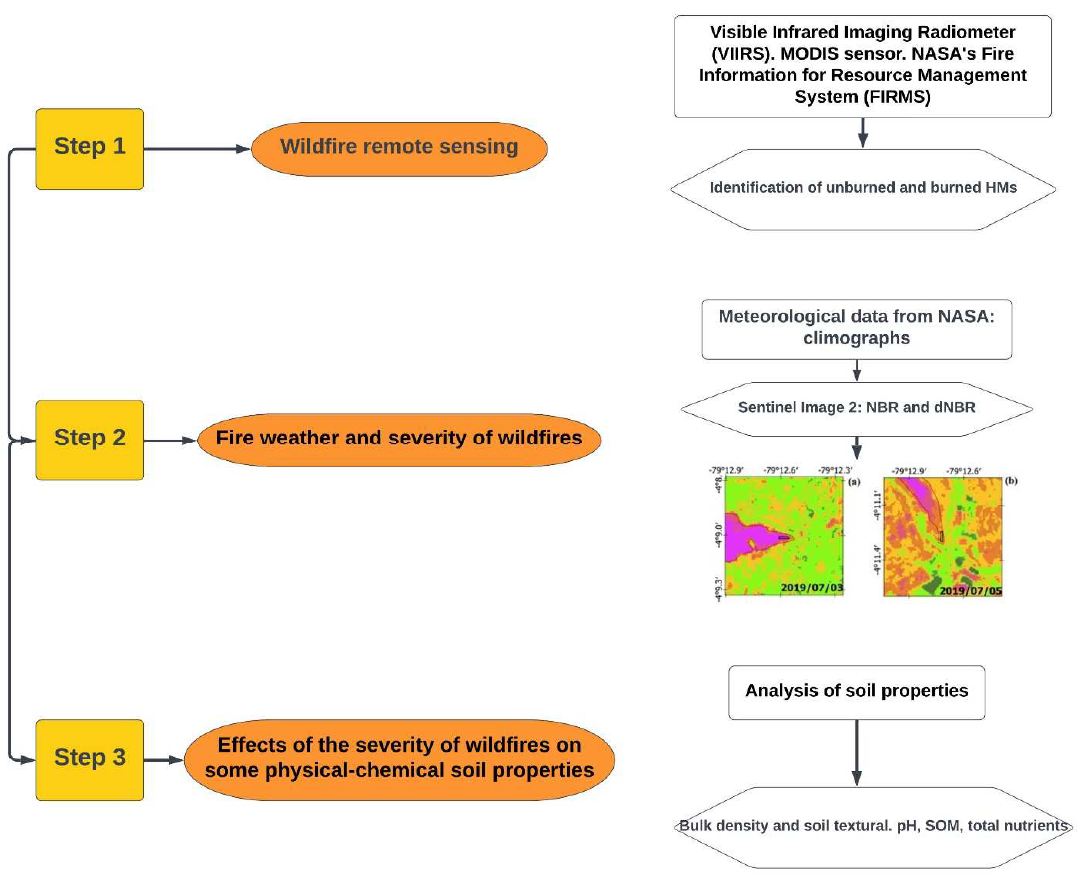
Figure 2. Schematic workflow of the overall study methodology. For the three steps of this study, the various data flows and analytical steps are shown, as well as how these steps are interrelated.